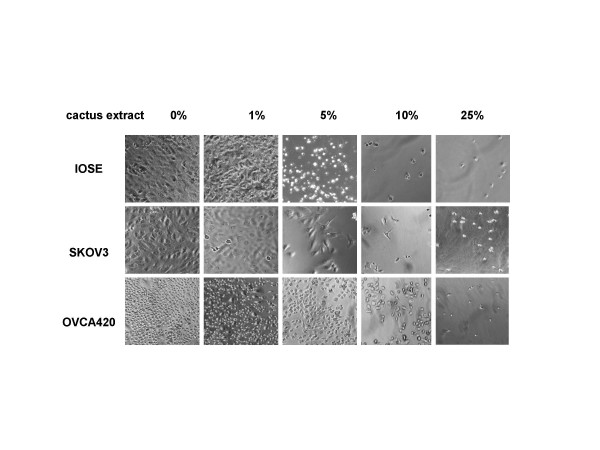
Effect of cactus pear extracts on the morphology of ovarian cells. Immortalized ovarian cells and ovarian cancer cells were grown in the absence (control) or presence of different concentrations of cactus extracts. The photographs were taken on day 3 after the removal of medium containing floating cells.